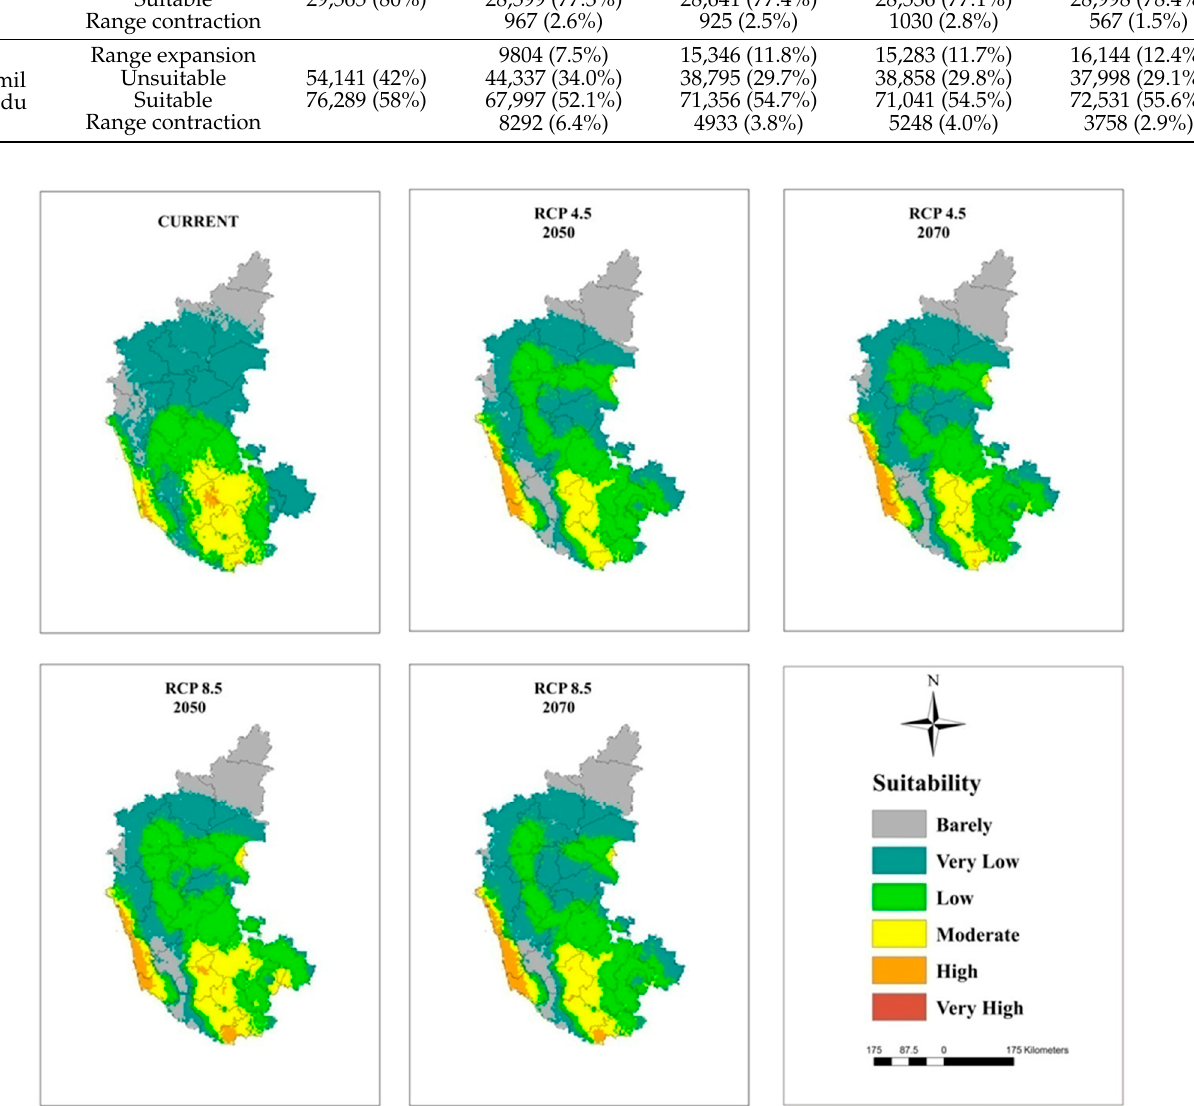
Figure 6. Climatically suitable areas for coconut production in Karnataka under the current and future climates of the 2050s and 2070s for RCP 4.5 and RCP 8.5 as modeled by MaxEnt.